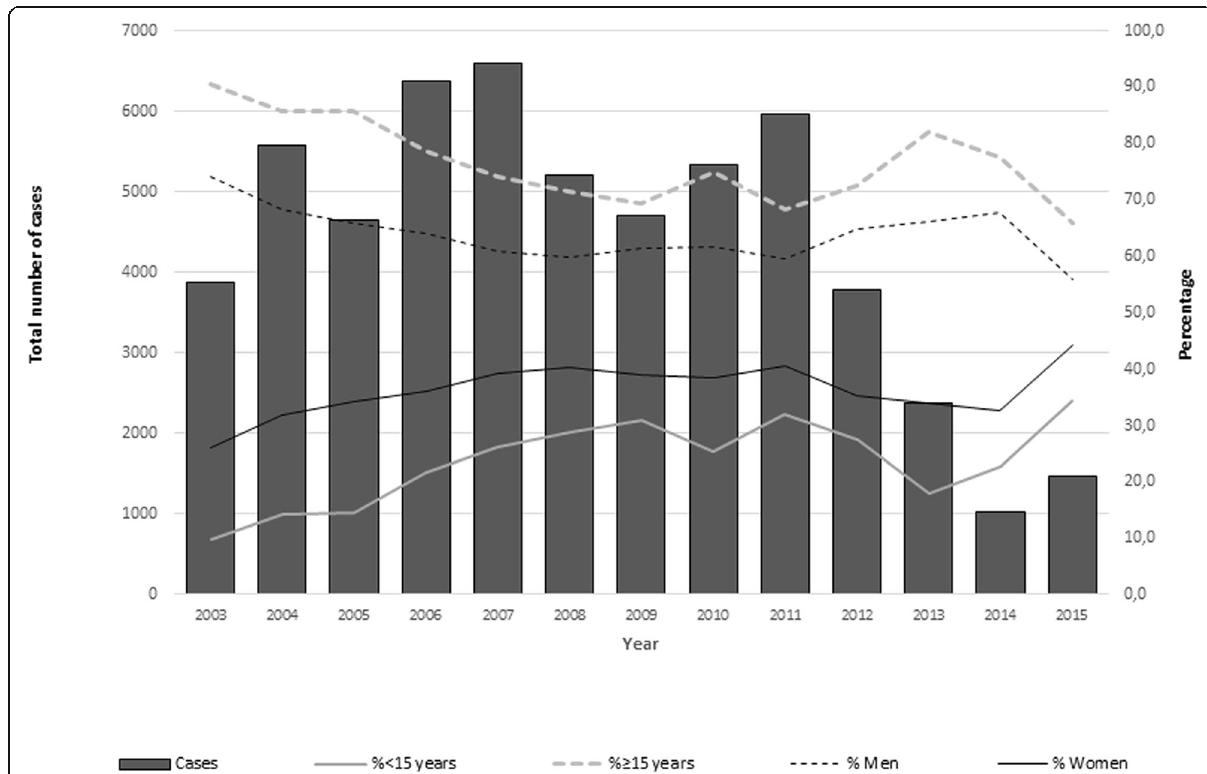
Fig. 5 Cases of malaria and rate of proportion of men and individuals under 15 years between 2003 and